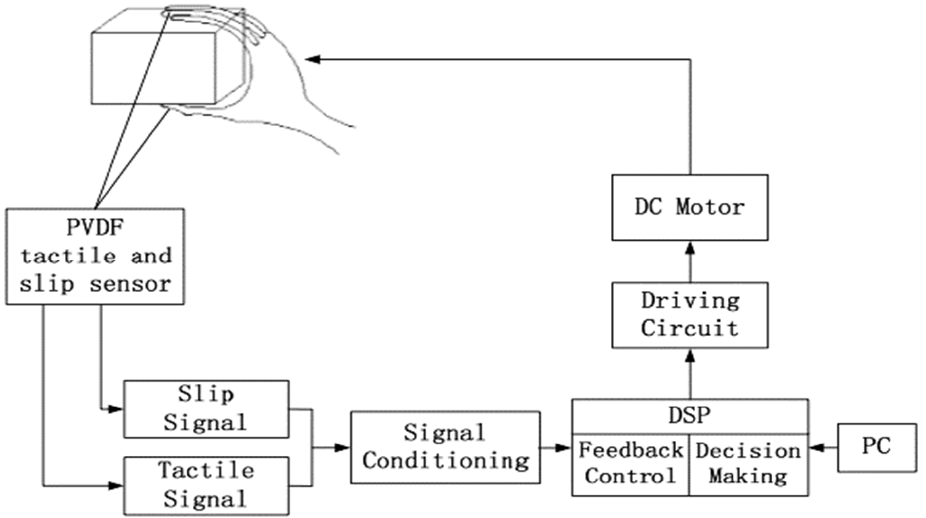
Figure 2. Schematic of the prosthetic hand control system presented in [93] (Reproduced with permission from [93], IEEE, 2012).